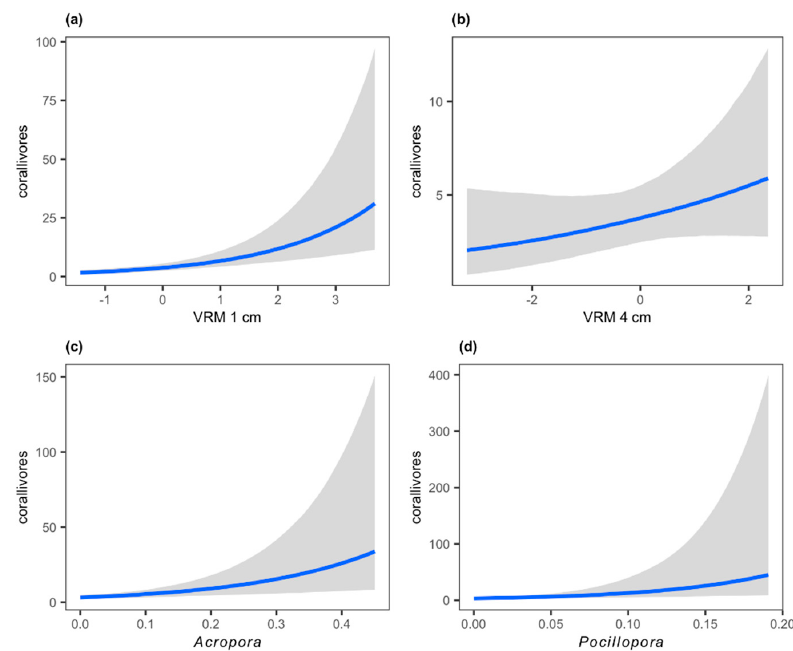
Figure 4. Conditional effect plots for ( a ) the standardized mean VRM at 1-cm resolution, ( b ) the standardized mean VRM deviation at 4-cm resolution, ( c ) the proportion of Acropora coral cover and ( d ) the proportion of Pocillopora coral cover showing the estimates of corallivore abundance per survey site.